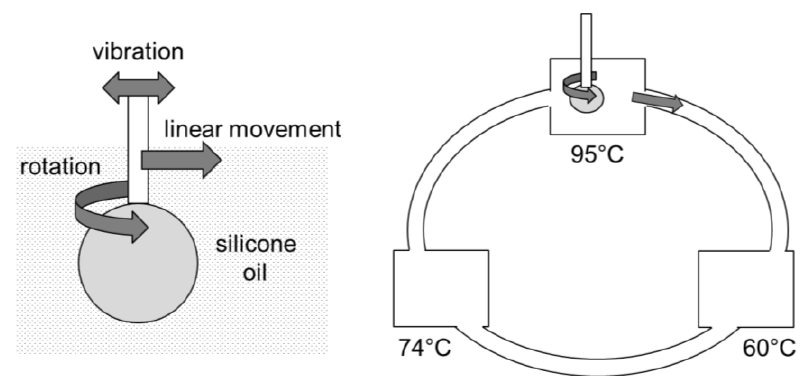
Figure 13. Wire-guided droplet